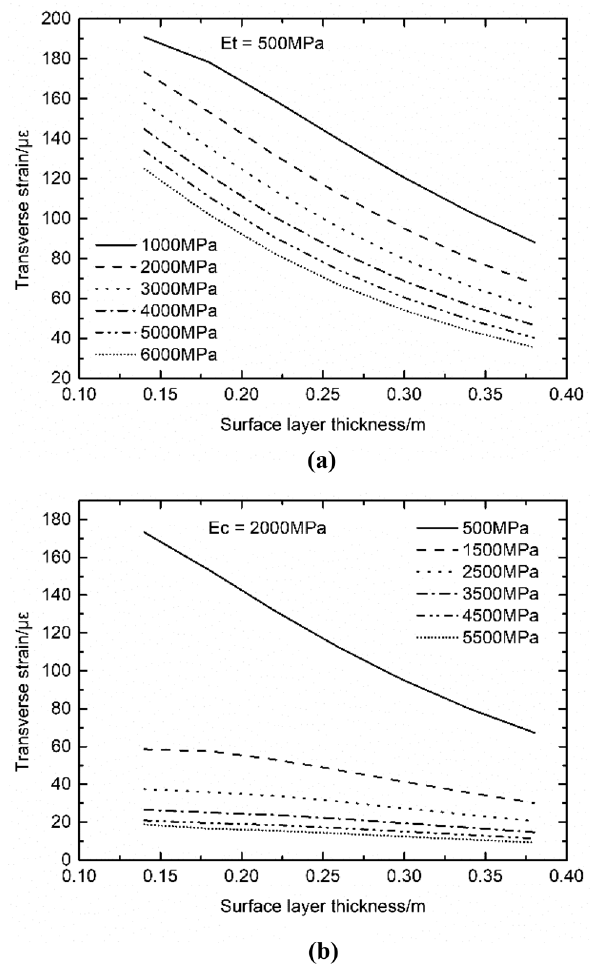
Fig. 8 Response of transverse tensile strain under the influence of a the thickness of the pavement and its modulus (equivalent resilient modulus on top of the base was 500 MPa), and b the thickness of the pavement and the equivalent resilient modulus on top of the base (modulus of the pavement was 2000